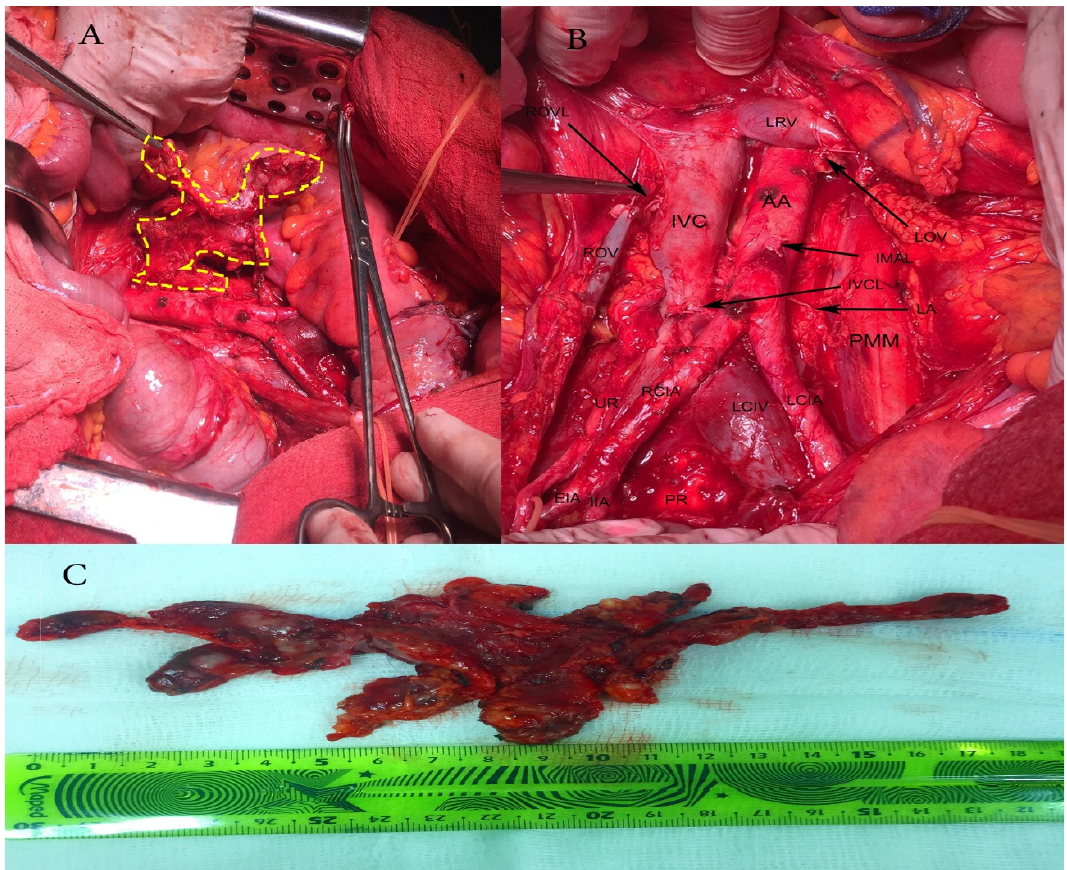
Figure 1. Paraaortic lymphadenectomy. ( A ) Resection of bulky paraaortic lymph nodes suspected for lymph node metastases; ( B ) Paraaortic region after lymphadenectomy; AA—abdominal aorta; IVC—inferior vena cava; LRV—left renal vein; LOV—left ovarian vein, cut and ligated where it drains into the left renal vein; IMAL—inferior mesenteric artery, cut and ligated; IVCL—inferior vena cava